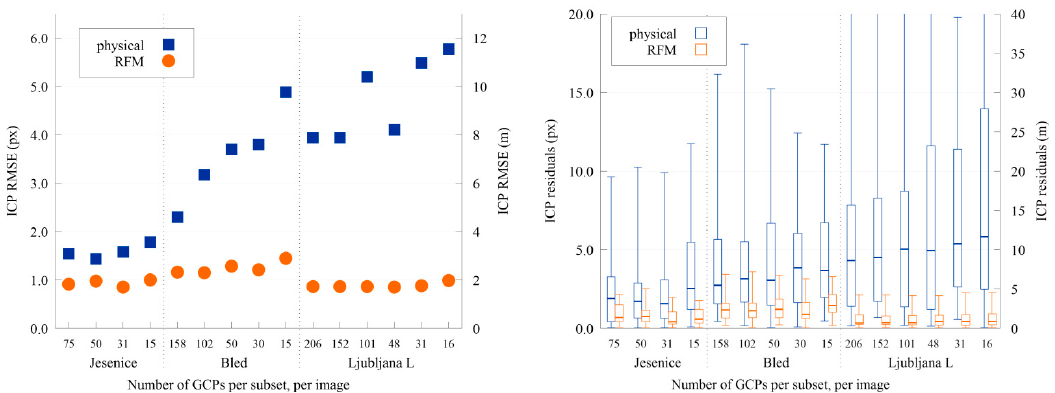
Figure 13. Left : Comparison of ICP RMSE in pixels/meters obtained with the physical sensor model (squares) and RFM (circles) at different subsets of automatically extracted GCPs for three multispectral WorldView-2 1B images (see Tables 5 and 7). Right : Boxplots of corresponding ICP residuals.